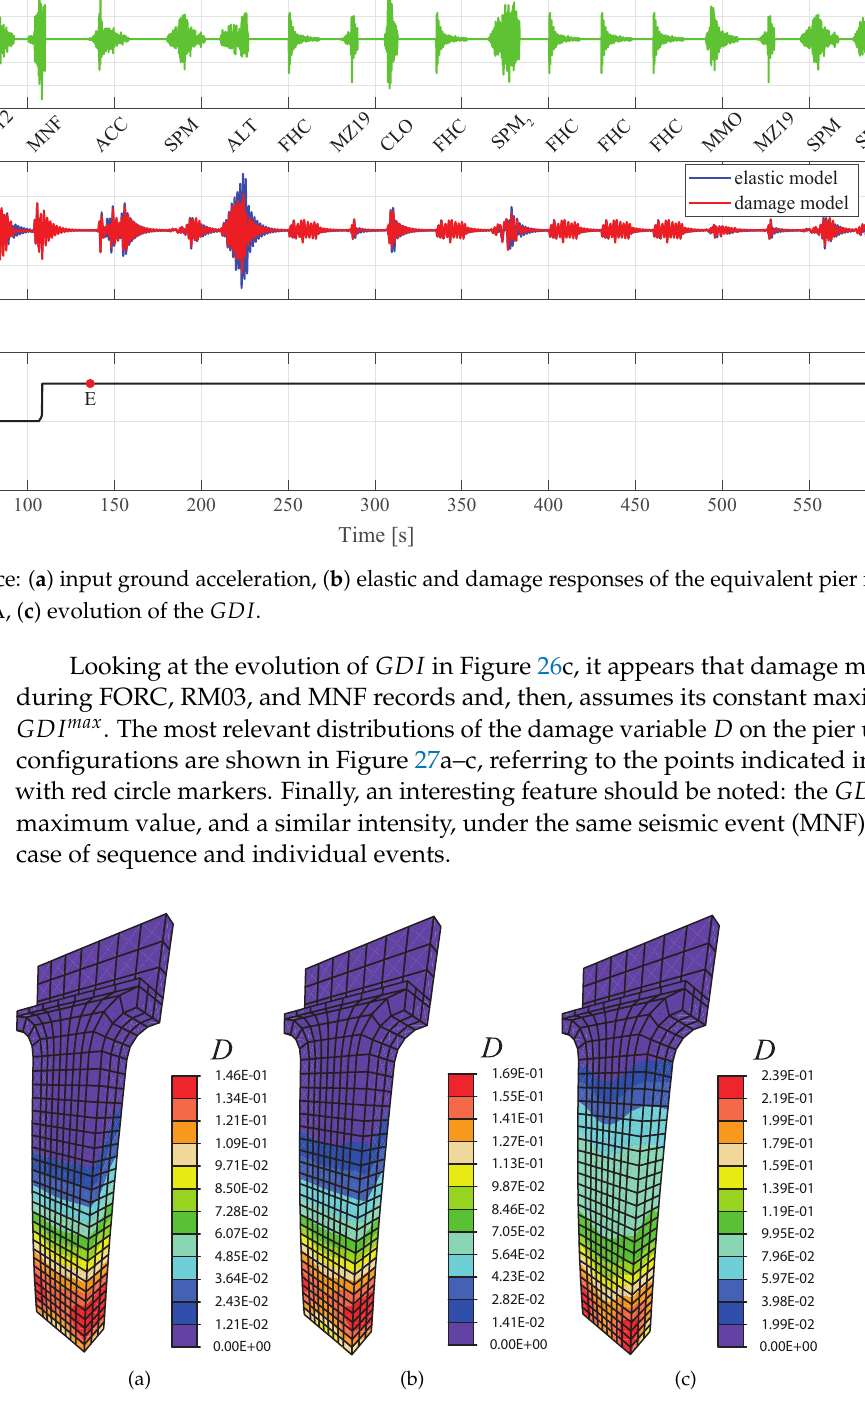
Figure 27. Distribution of the damage variable D on the pier undeformed configurations correspond- ing to points ( a ) B, ( b ) C, and ( c ) E in Figure